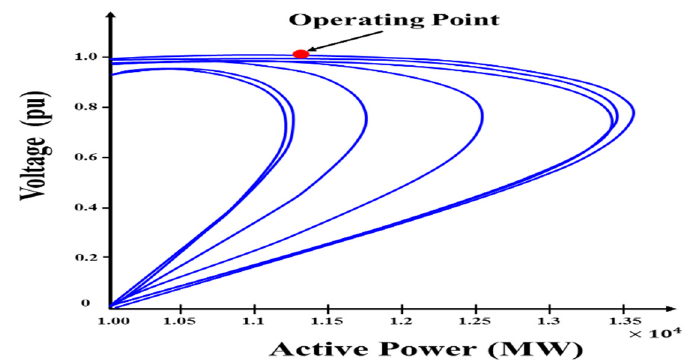
Figure 17. PV curves using Thévenin equivalent impedance. Table 2. Specific margins with each PV curve.